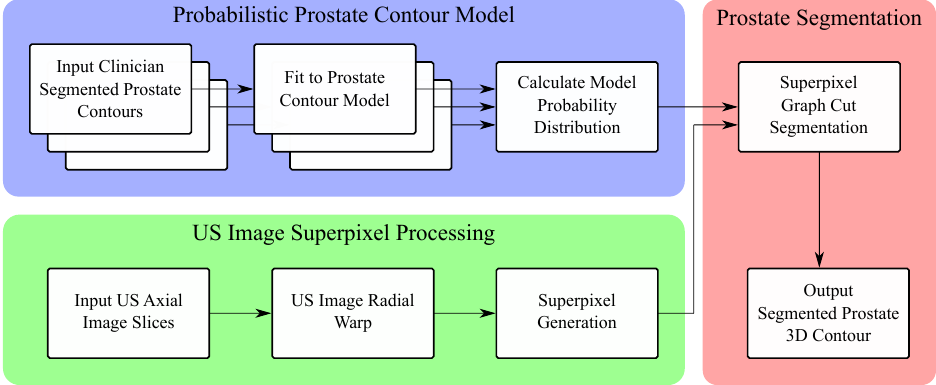
Figure 1. Overview of prostate segmentation